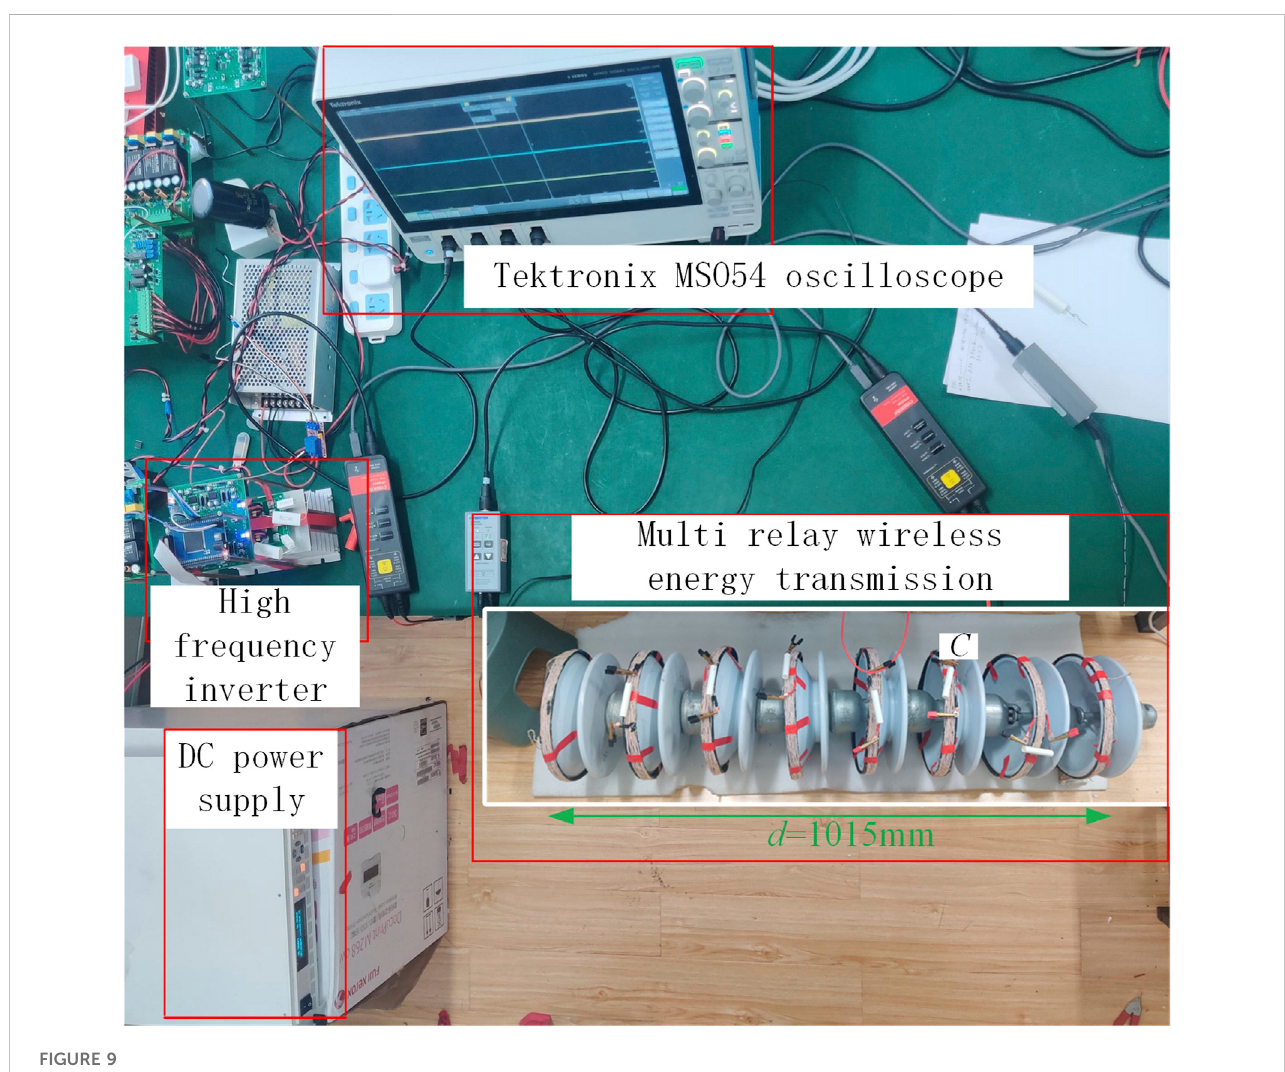
FIGURE 9 WPT experimental platform.